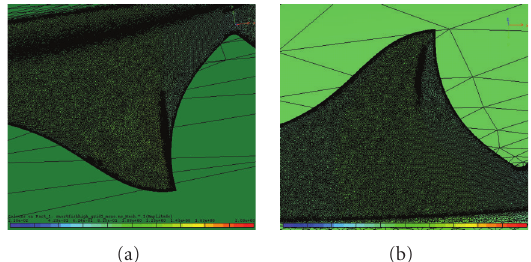
Figure 19: Adapted finer grid with respect to the Mach di ff erence. 4 adaptation cycles at the Mach number 0.9 and angle of attack 4 ◦ , 3303715 elements and 555347 nodes. Upper side of the wing and lower